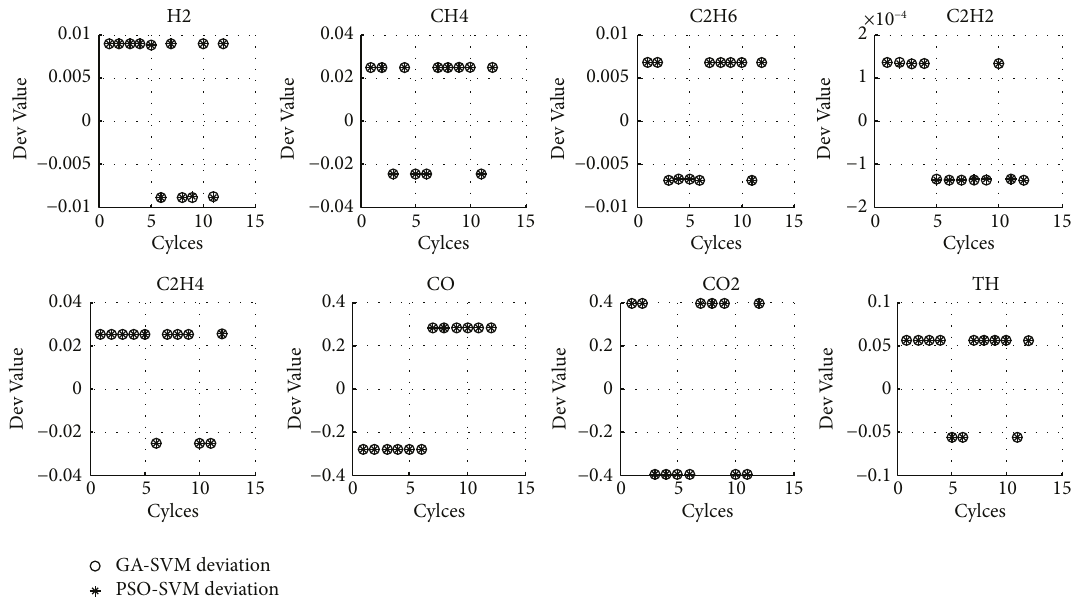
Figure 7: The deviation between the predicted value by the GA-SVM/PSO-SVM regression model and the high value obtained by in- formation